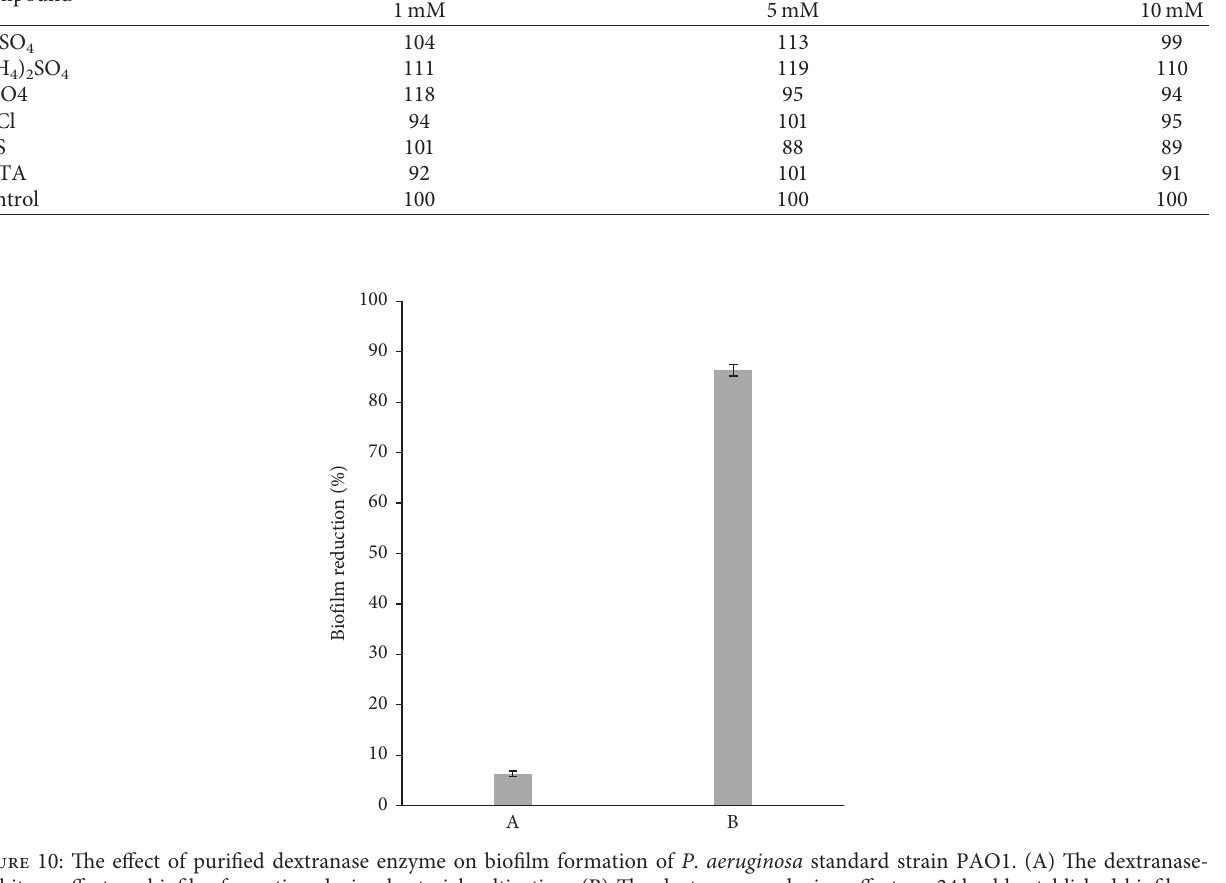
Table 2: Effects of some metal ions and selected compounds on the activity of Talaromyces sp. dextranase enzyme. Compound